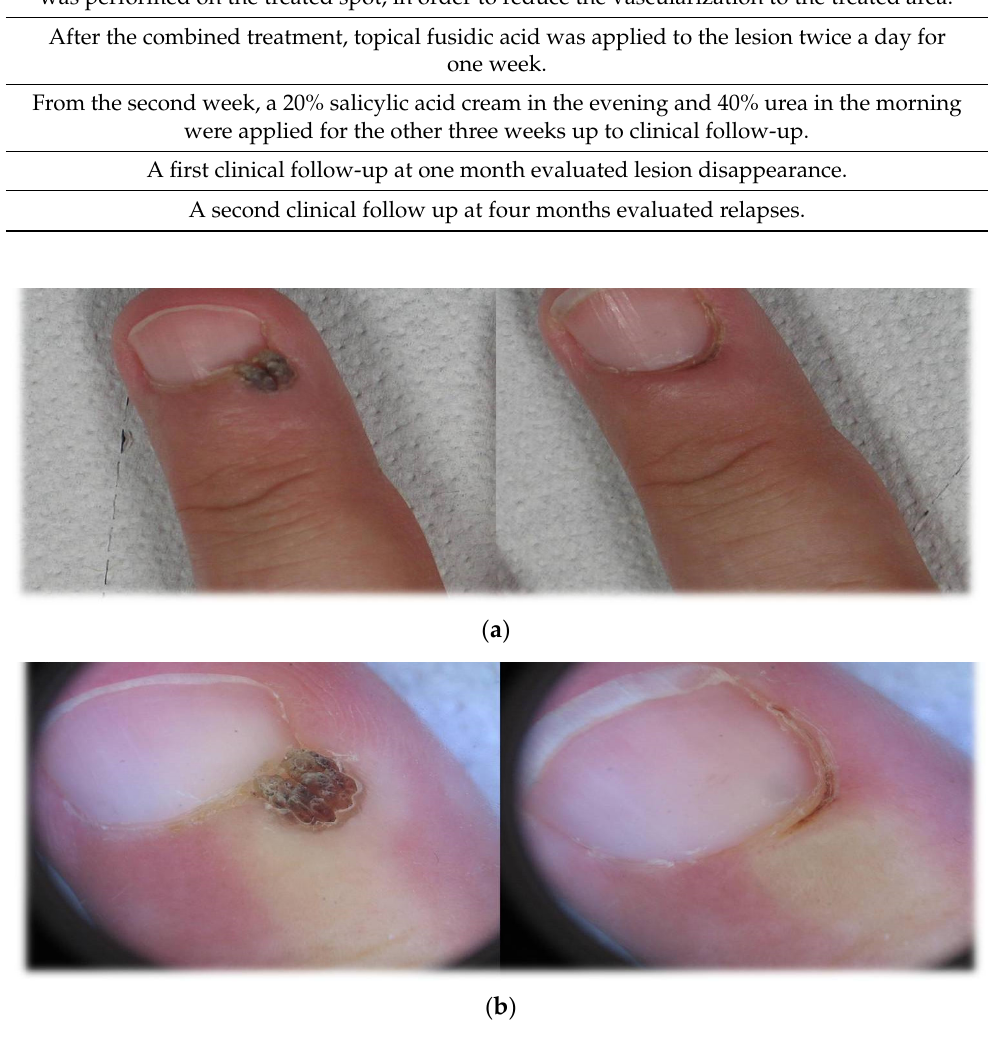
Figure 3. Patient n. 6 before treatment ( left ), immediately after combined treatment ( central ), and 4 months after treatment ( right ). Figure 4. Patient n. 27 before treatment ( left ), immediately after combined treatment ( central ), and 4 months after treatment ( right ).